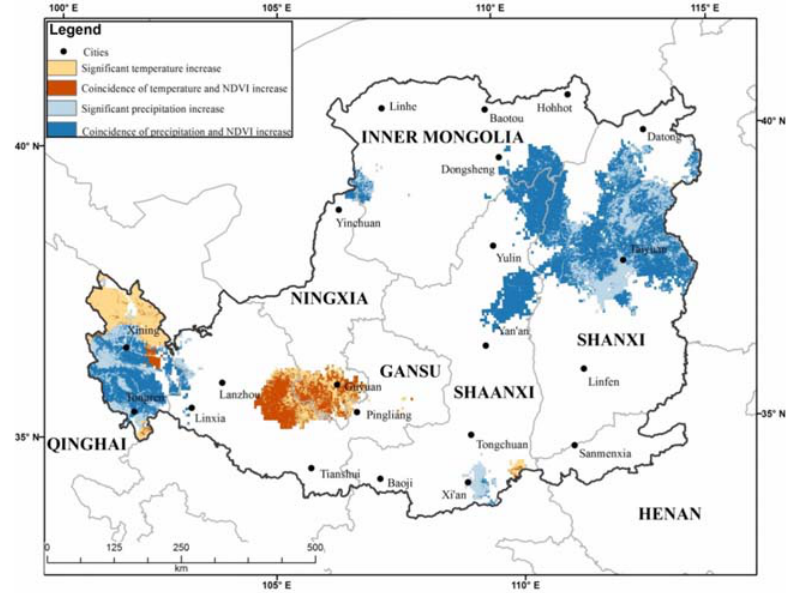
Figure 3. Significant temperature and precipitation increases from 1999 to 2009 in the Loess Plateau. The significant temperature and precipitation increases were identified by applying seasonal Mann-Kendall trend test to monthly 500 m temperature and precipitation time series interpolated from weather station based monthly observations. Blue pixels represent significant precipitation increases, which accounted for 16.8% of the Loess Plateau. Dark blue pixels indicate the coincidence of significant NDVI and precipitation increases, which accounted for 10.7% and 22.2% of the entire Loess Plateau and positive vegetation change area, respectively. Brown pixels indicate significant temperature increases, which accounted for 4.7% of the Loess Plateau. Dark brown pixels indicate the coincidence of significant NDVI and precipitation increases, which accounted for 1.8% and 3.8% of the entire Loess Plateau and positive vegetation change area,